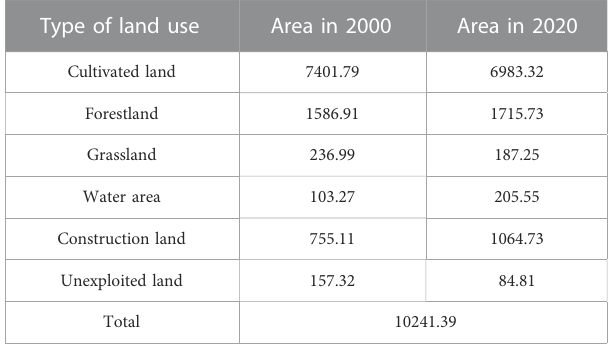
TABLE4 AreaofdifferentlandusetypesinSipingCityin2000and2020(km2). Type of land